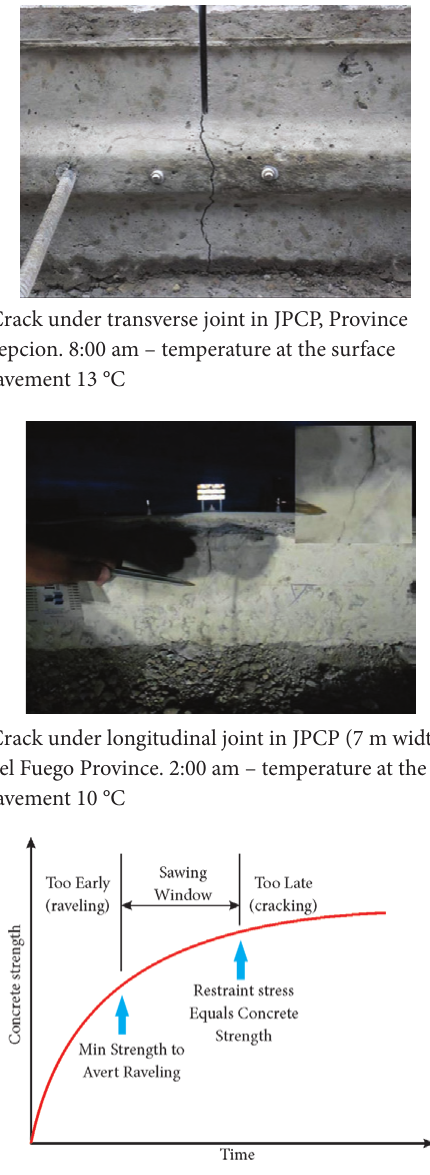
Fig. 3. Sawing window (Okamoto et al . 1994) Table 1. Summary of the Houben approach and the Pradena and Houben approach